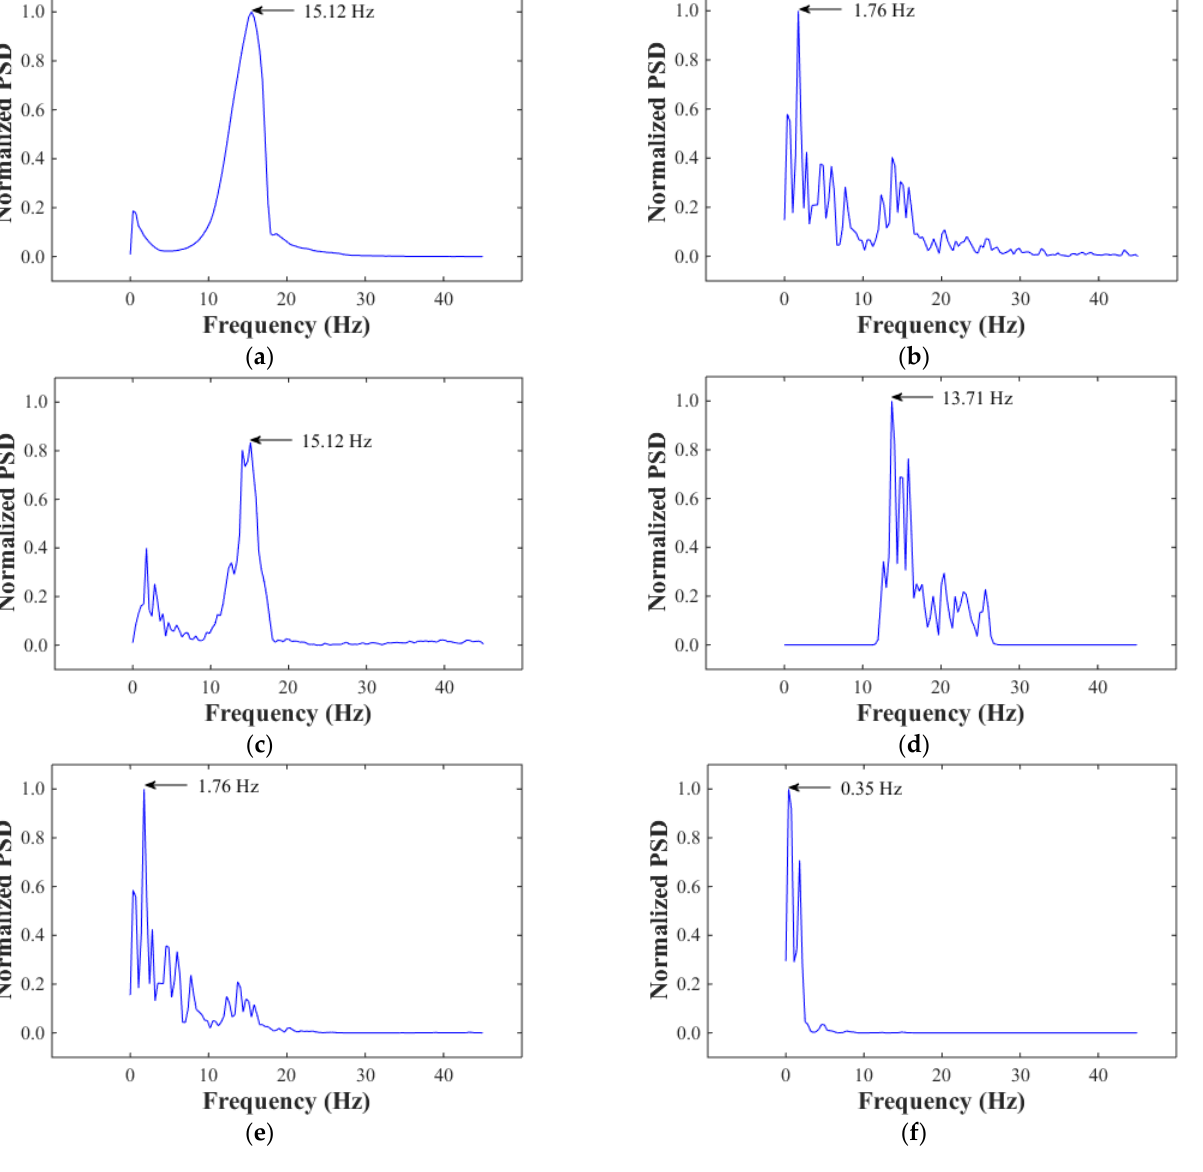
Figure 12. Power spectral density (PSD) before and after optical-turbulence error mitigation: ( a ) Ref- erence; ( b ) Before mitigation; ( c ) After mitigation by the proposed method; ( d ) After mitigation by frequency domain filtering (bandpass filter: 12~18 Hz); ( e ) After time domain filtering mitigation (moving average: window size = 3); ( f ) After time domain filtering mitigation (moving average: window size =